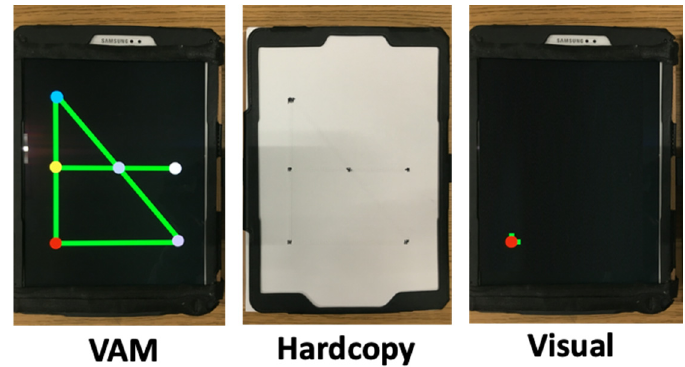
Figure 4. Experimental maps in three learning mode conditions: VAM ( left ), hardcopy tactile interface ( center ), and visual interface ( right ).